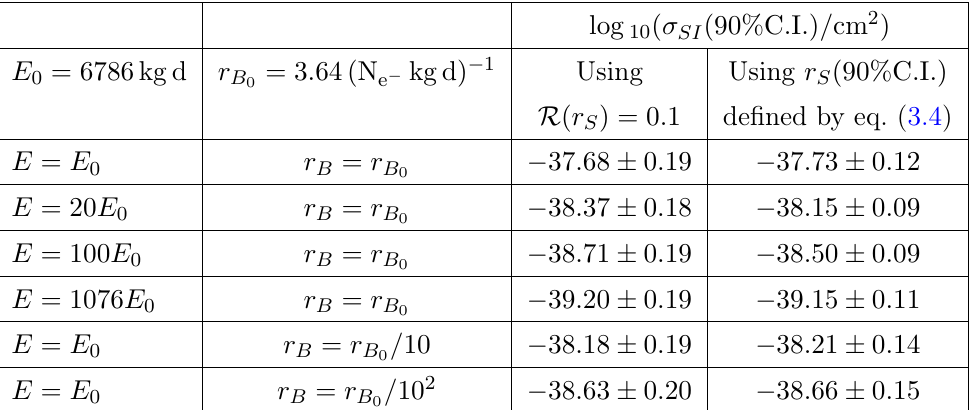
Table 2 . Upper bound results in two different methods for a Migdal-only signal at m (cid:31) = 1 GeV/ c 2 and n = 1 ; 2 using pseudo-datasets generated from the background-only likelihood.